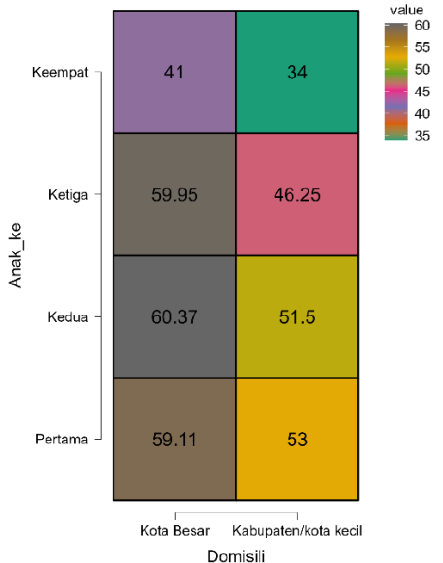
Figure 2. Narcissistic Heatmaps Based on Social Demographics